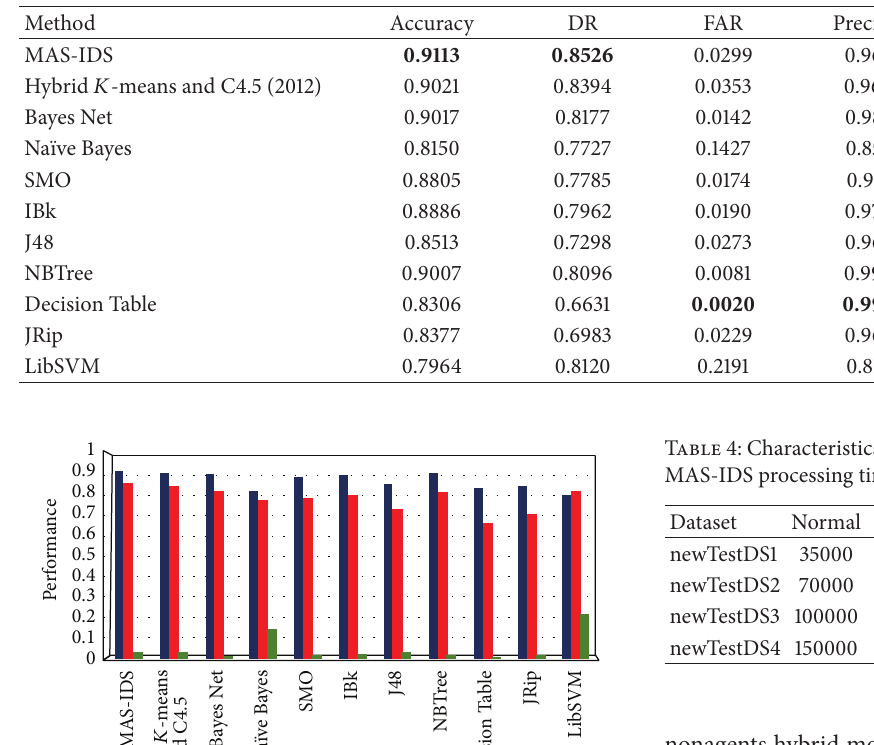
Table 3: Comparison of the MAS-IDS performance with other methods using different measures.